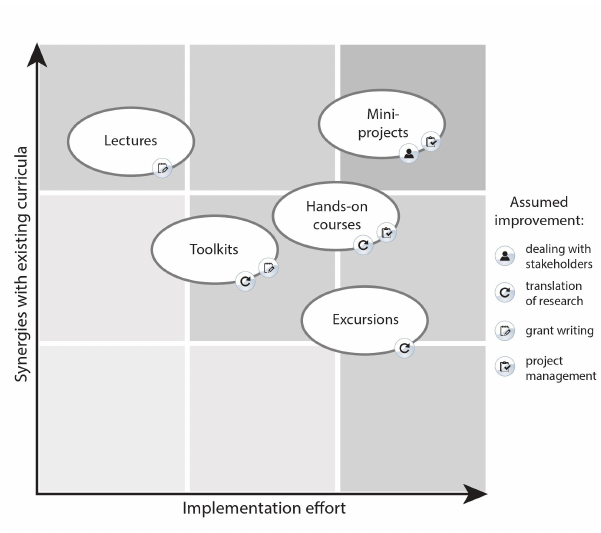
Figure 2. Early career climate change and sustainability researchers’ recommendations for improving university ed- ucation in Austria specifically regarding collaboration with stakeholders using the approach from Killion et al.